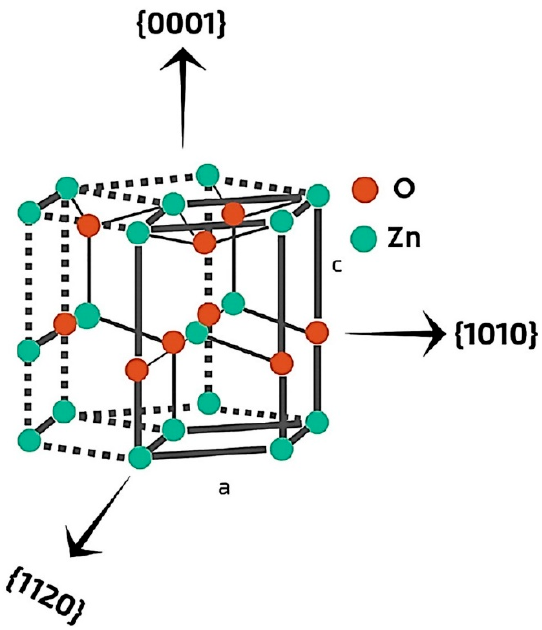
Figure 2. A typical wurtzite crystal structure of ZnO with indicated directions. Reprinted with permission from Reference [46]. Copyright 2017, with permission from Elsevier.